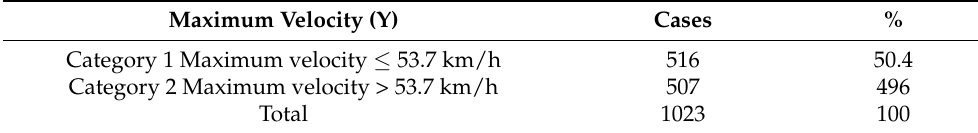
Table 5. Codification of maximum velocity as a categorical